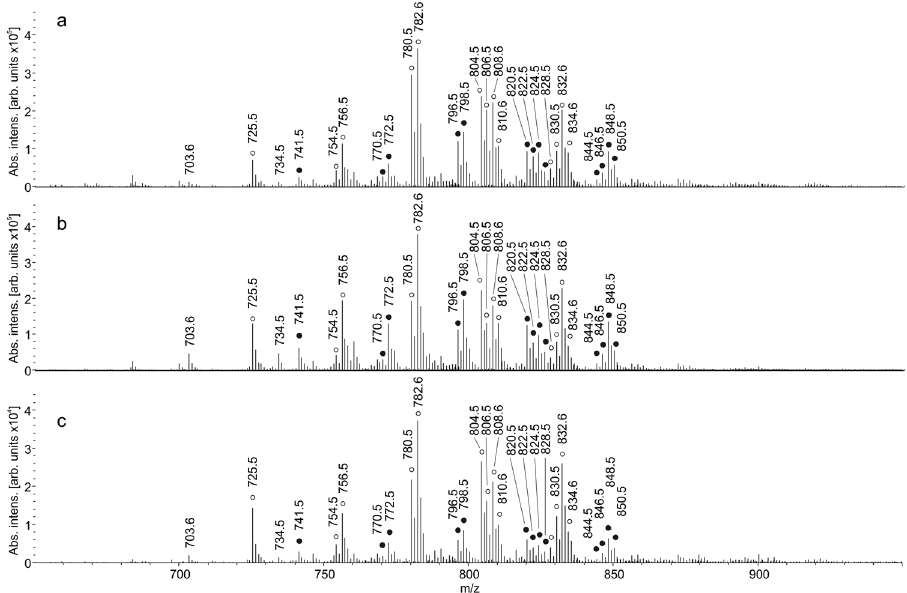
Figure 2. Positive ion tissue spray mass spectra of ( a ) eutopic endometrium; ( b ) endometriotic ovarian cyst; ( c ) pelvic